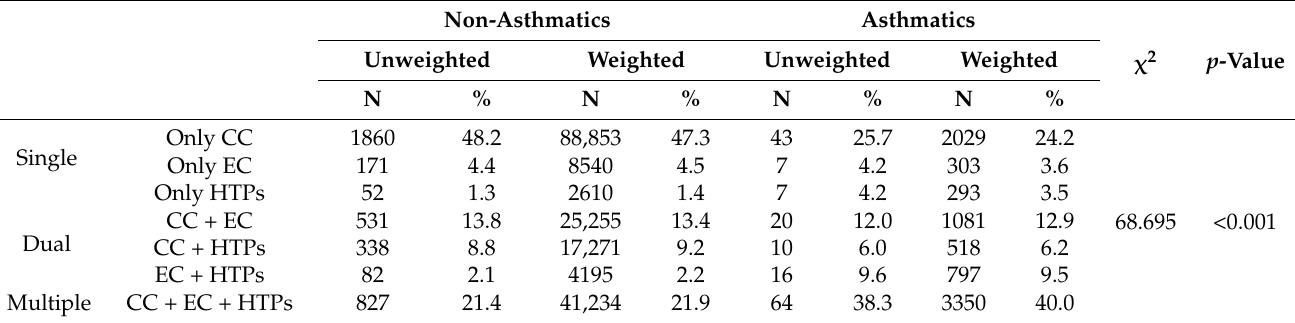
Table 3. Multiple tobacco product use by asthma